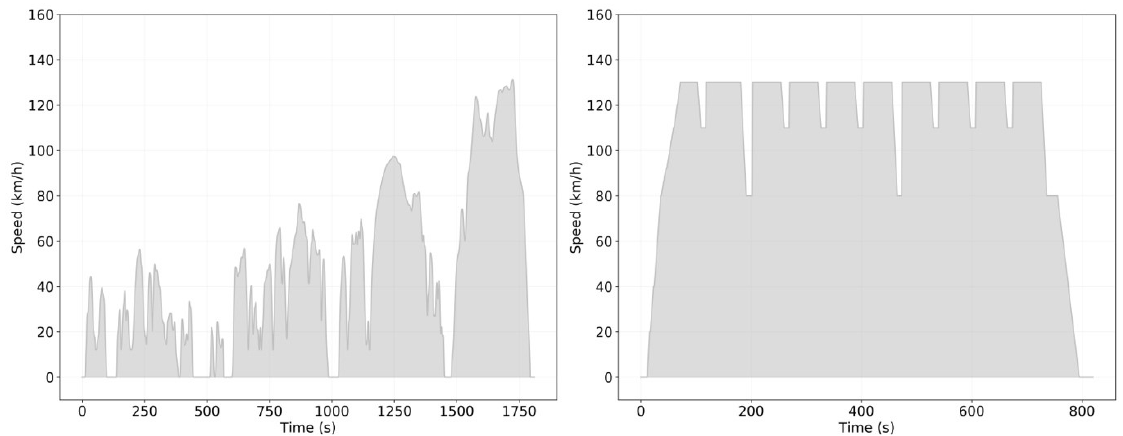
Figure 1. Test cycles speed profiles. Left panel: WLTC, right panel: BAB.